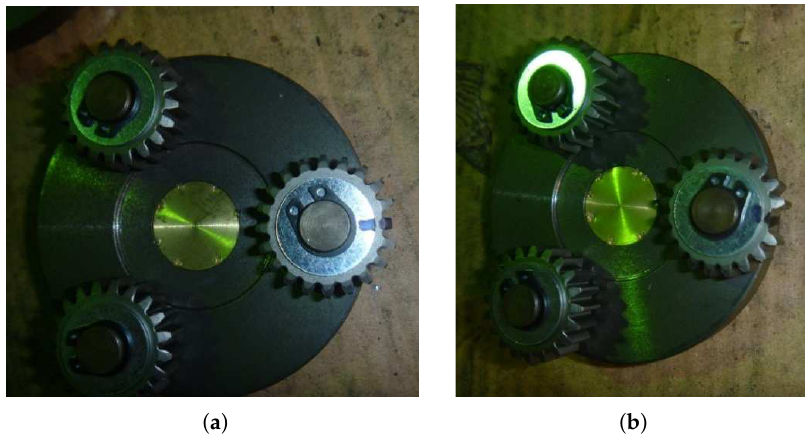
Figure 11. Planet gears with: ( a ) half tooth breakage fault; ( b ) the whole tooth breakage fault.